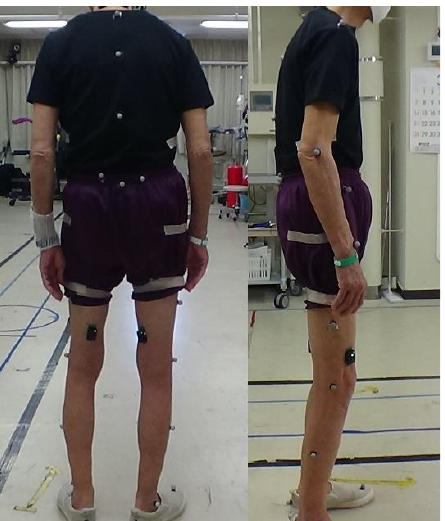
Figure 1. Reflective markers were placed on the spinal spinous and pelvic processes.